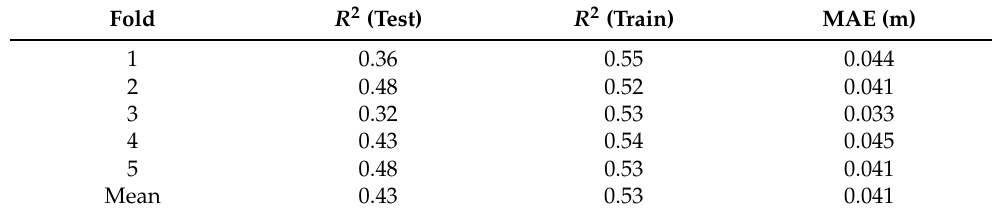
Table 3. A demonstration of cross-validation performance metrics for each fold and average per- formance for our selected model. Note that whilst the cross-validation assessment was performed subsequent to the Box–Cox transform on the output roughness, for this table, this transform was inverted on the calculated MAE so as to present errors which are intuitively